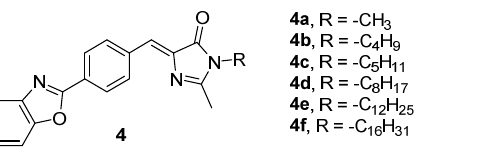
Figure 4. GFPc analogues presenting AIEE properties, combined with ACQ for some of them [16,17]. The different behaviors can be rationalized considering the crystal packing of the dyes.